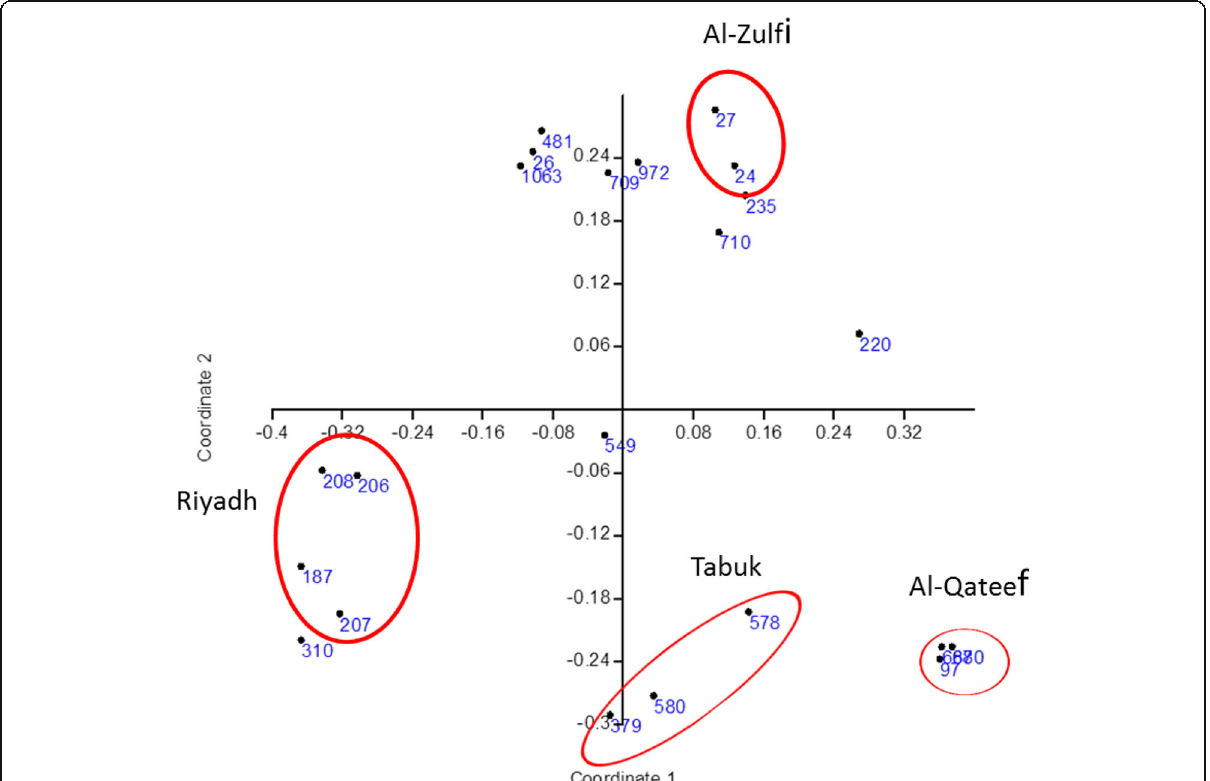
Fig. 2 PCoA of 22 C. pepo with 15 HFO-TAG